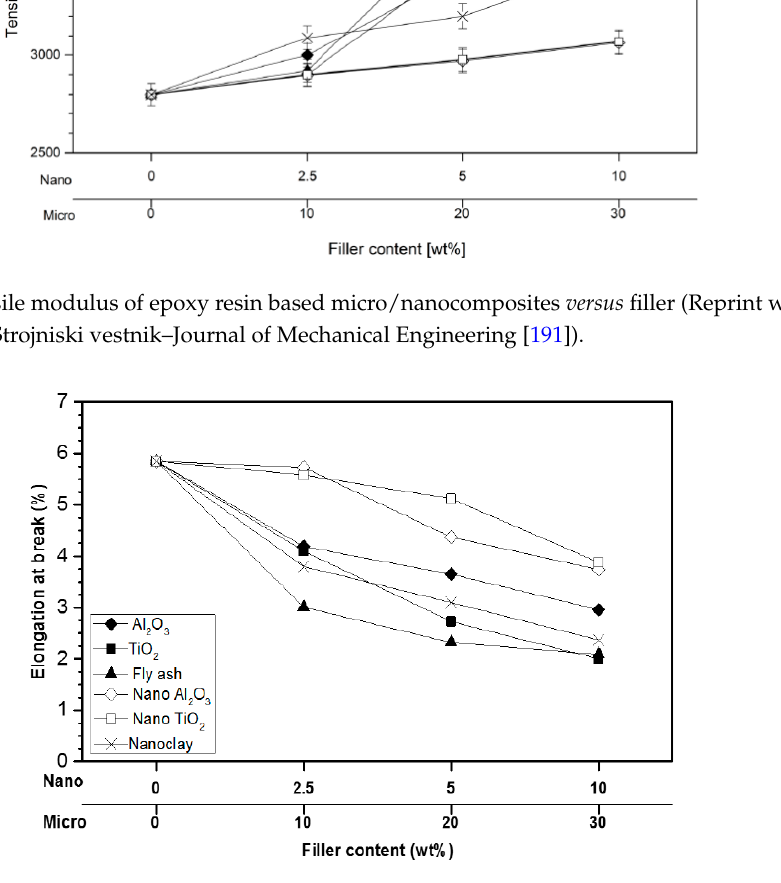
Figure 44. Elongation at break in epoxy resin based micro/nanocomposites versus filler content (Reprint with the permission of Strojniski vestnik—Journal of Mechanical Engineering [191]).